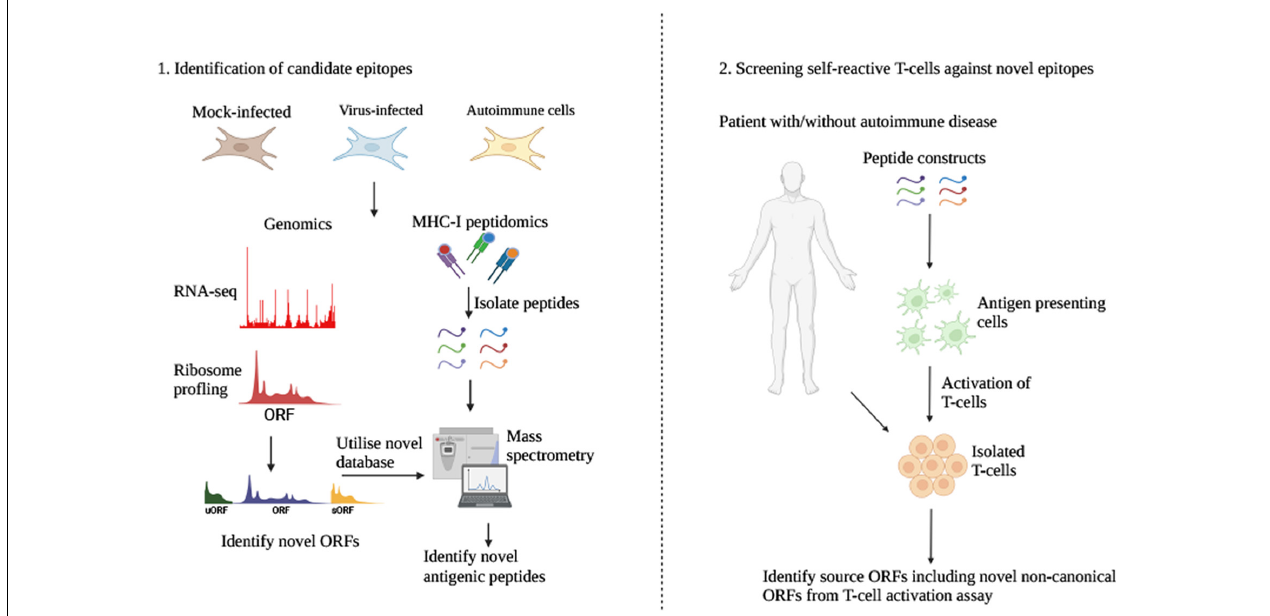
FIGURE 2 | Assessing the role of non-canonical viral ORFs in virus-induced autoimmunity. To support our presented hypothesis, a proteogenomic approach should be adopted to identify novel ORFs combining RNA-seq and ribosome profiling methods for the displayed conditions (1). The novel database would then be utilized to identify novel antigenic epitopes presented by MHC-I complexes through solubilization of peptides stably bound to MHC-I, which would significantly improve the determination of highly unstable non-canonical ORFs of lengths < 100 aa, which would otherwise be challenging to detect using conventional proteomics. The identified peptides should then be utilized for uptake by antigen presenting cells in vitro to assess self-reactivity of T-cells isolated from patients with and without autoimmune diseases and with a history of chronic viral infection for the virus under study (2). This methodology would help determine both the proportion and immunological repertoire of non-canonical peptides playing a role in virus-induced autoimmunity. By deciphering their expression under various conditions and cell lines (1), one could determine both the non-canonical nature and expression of ORFs and if indeed their absence or weak expression could explain an escape in immunological self-tolerance for the specific peptide and its source protein. sORF, short ORF; uORF, upstream ORF; APCs, antigen presenting cells (Created using